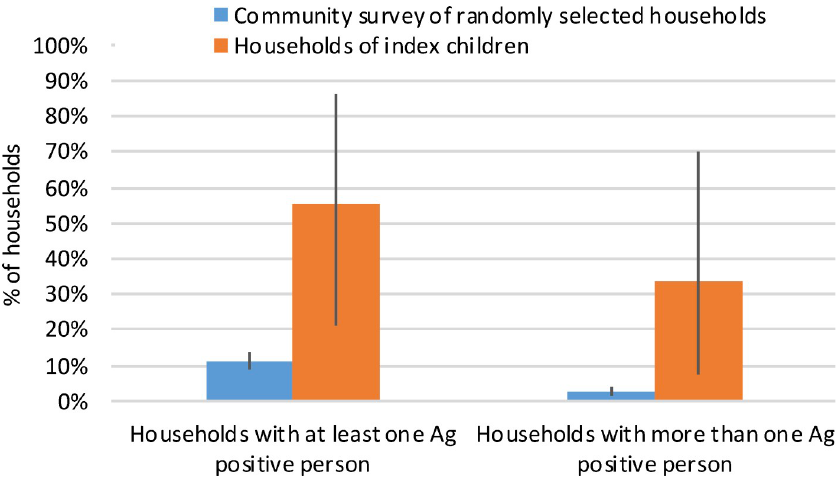
Fig 7. Percentage of households of index children versus randomly selected households in community survey where i) at least one antigen-positive person was identified, and ii) more than one antigen-positive person was identified.